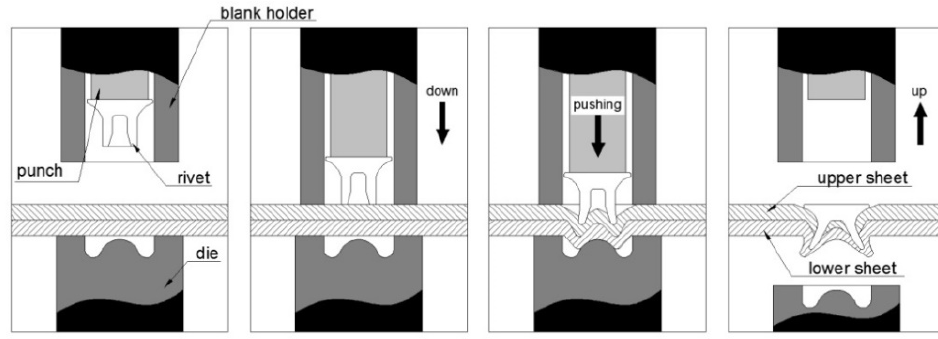
Figure 1. Illustration of the self-piercing riveting process.